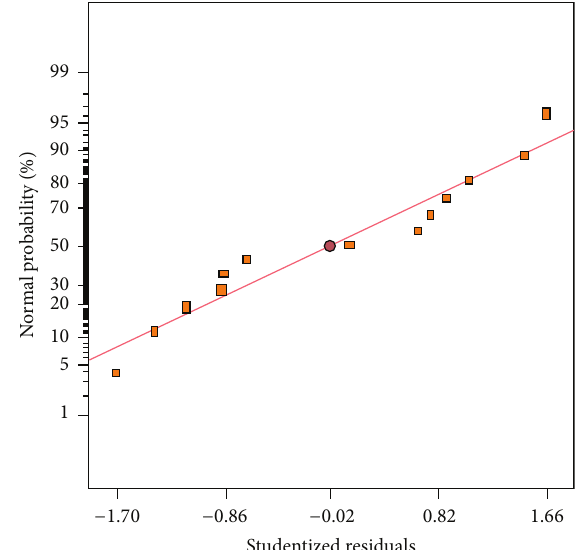
Figure 7: Normal probability of studentized residuals for lipid con-